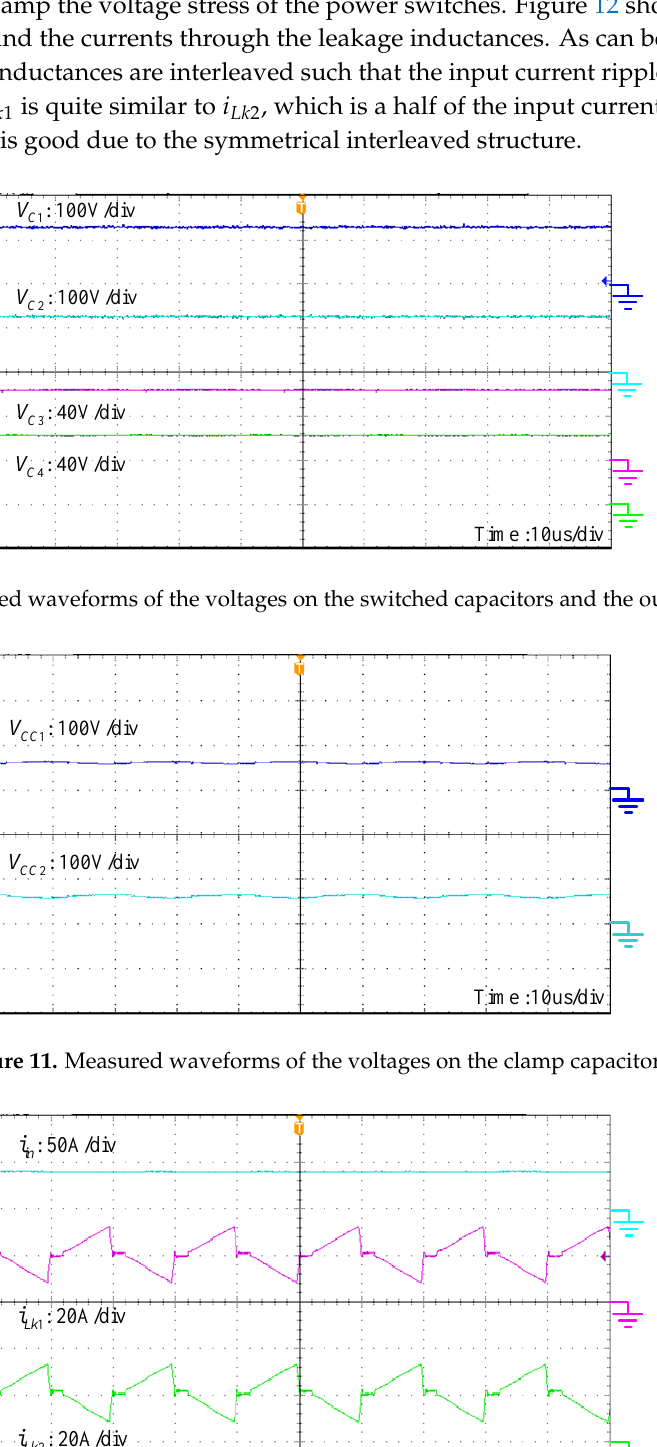
Figure 12. Measured waveforms of the input current and the currents through the leakage inductances.